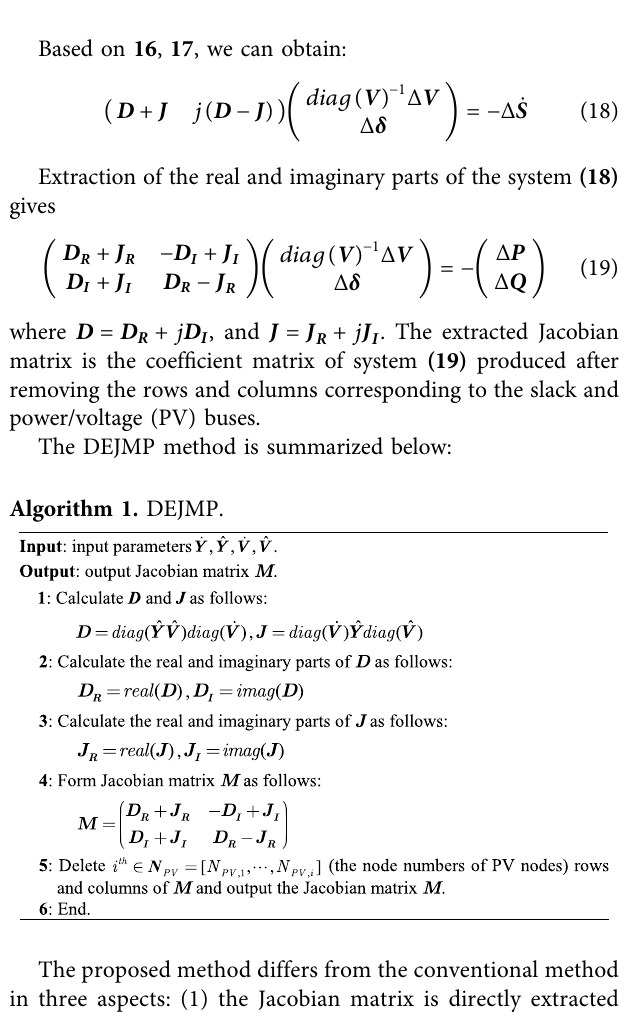
FIGURE 7 | the voltage angle obtained by DEJMP-based PF and C-PF on S-2383 bus